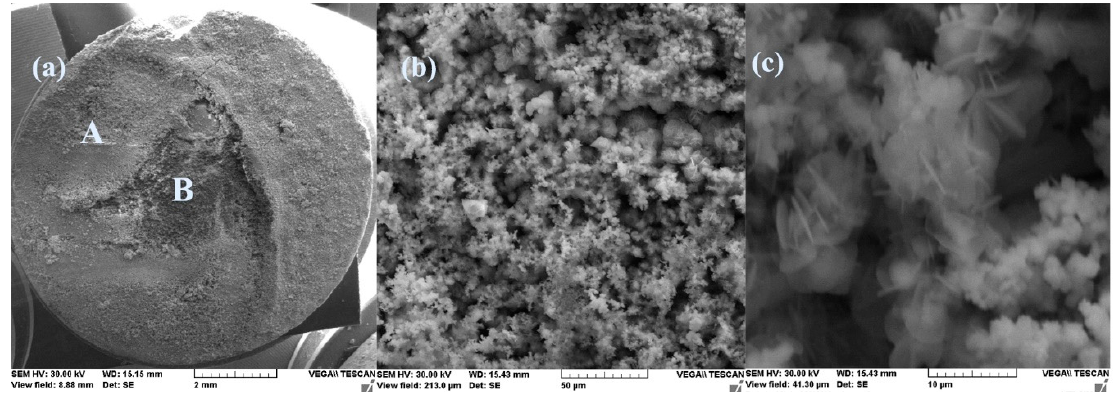
Figure 11. SEM microphotographs of the PS sample maintained for 85 days in seawater ( a ) 100×, ( b ) 1000×, and ( c ) 5000×. After 85 days of immersion in seawater, a thick layer of corrosion products was deposited on the surface of the sample, which, after drying, formed a fragile crust, easily removable (the A zone). During handling, a portion of the crust was partially detached (the B zone). The microphotographs from the A zone, magnified by 1000× and 5000×, respectively, indicate that at the microscopic level the crust is formed in an agglomeration of crystalline micro formations, a structure that gives the crust a great porosity. The energy spectrum and surface composition are shown in Figure 12 for the A zone and in Figure 13 for the B zone.